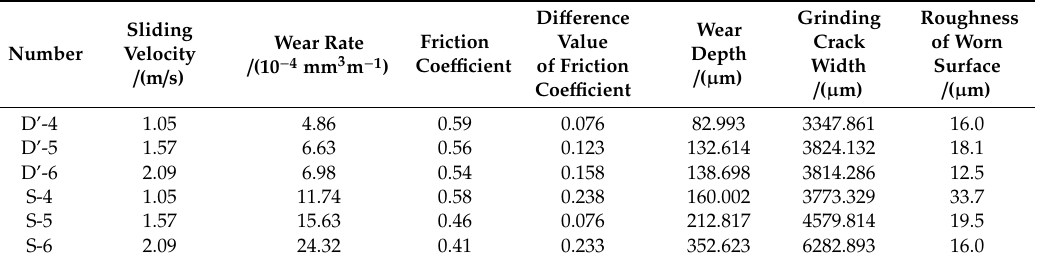
Table 5. Sliding-friction results for the ductile iron and carbon steel wheels with di ff erent sliding velocities and